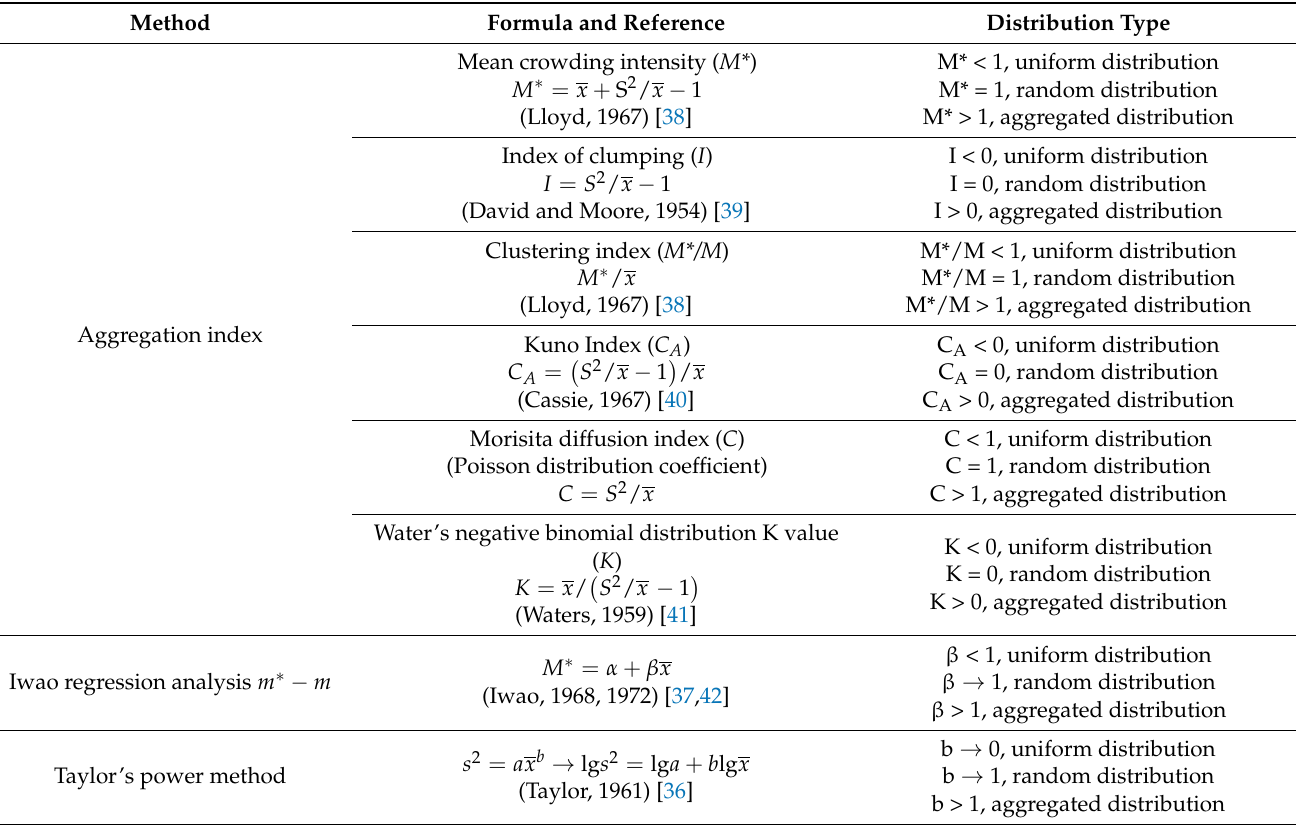
Table 1. Formulas used to show the spatial distribution